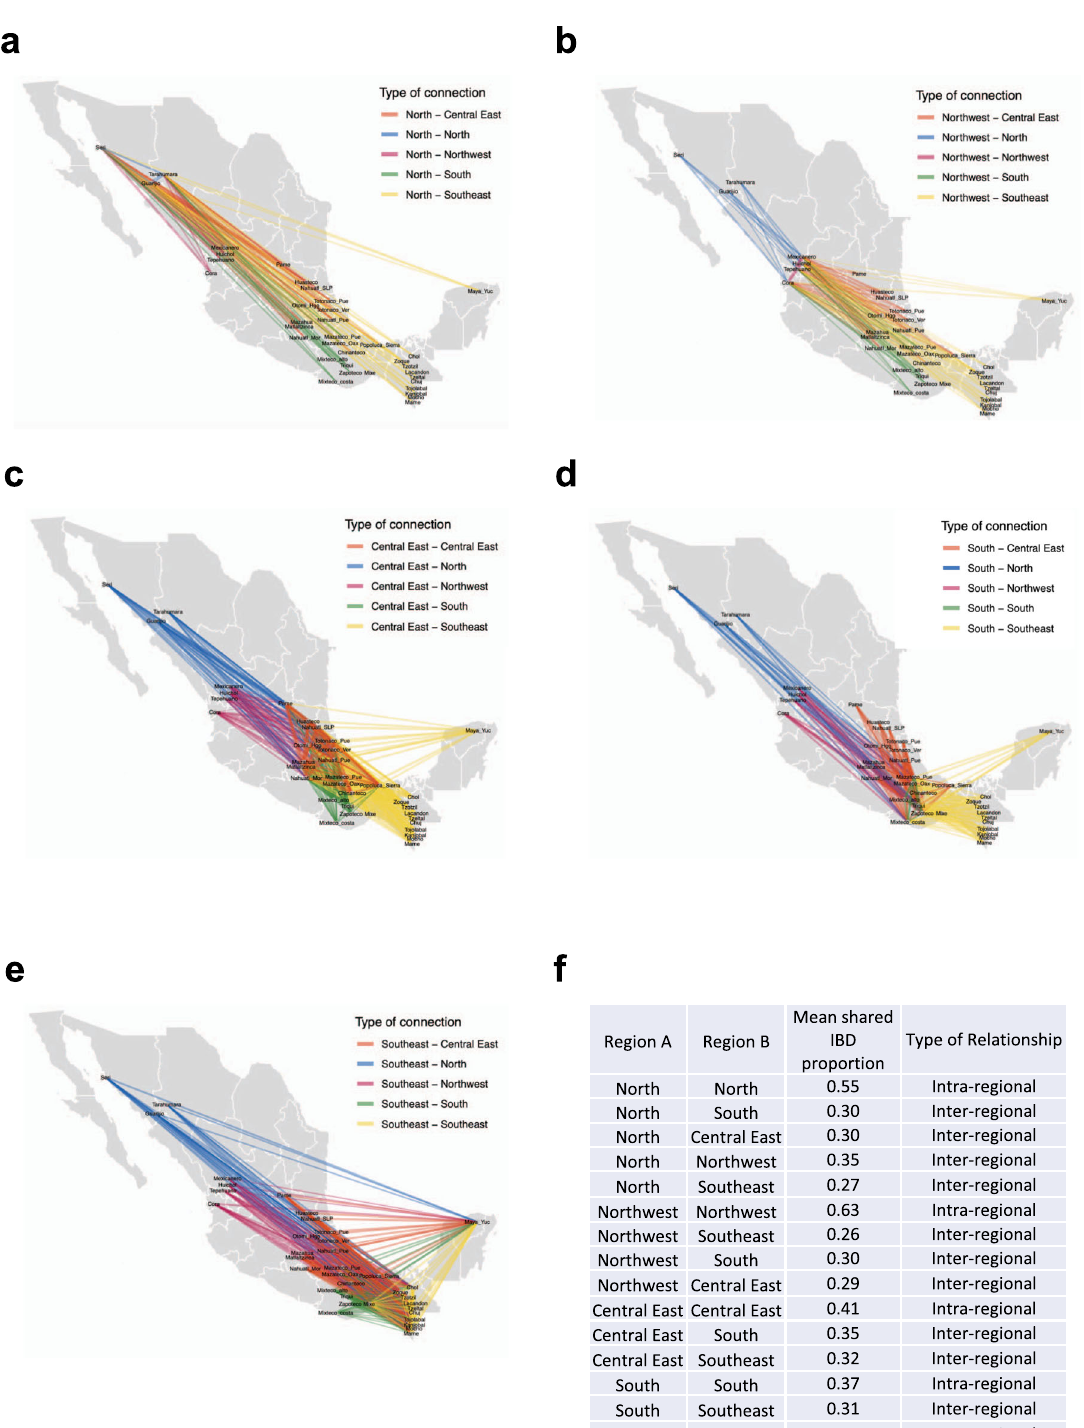
Fig. 4 IBD segments analysis. IBD segments analysis performed in Indigenous populations with at least 99% of Native American ancestry inferred from Admixture K = 4. Analyses were restricted for segments >7 cM. Shared IBD fragments shown proximal and distal connections between populations from the same and different regions. a North IBD segments, b Northeast IBD segments, c Central East IBD segments and d South IBD segments and e Southeast IBD segments. The width of each edge is proportional to the mean IBD length. f Table showing the mean values of IBD sharing within and between